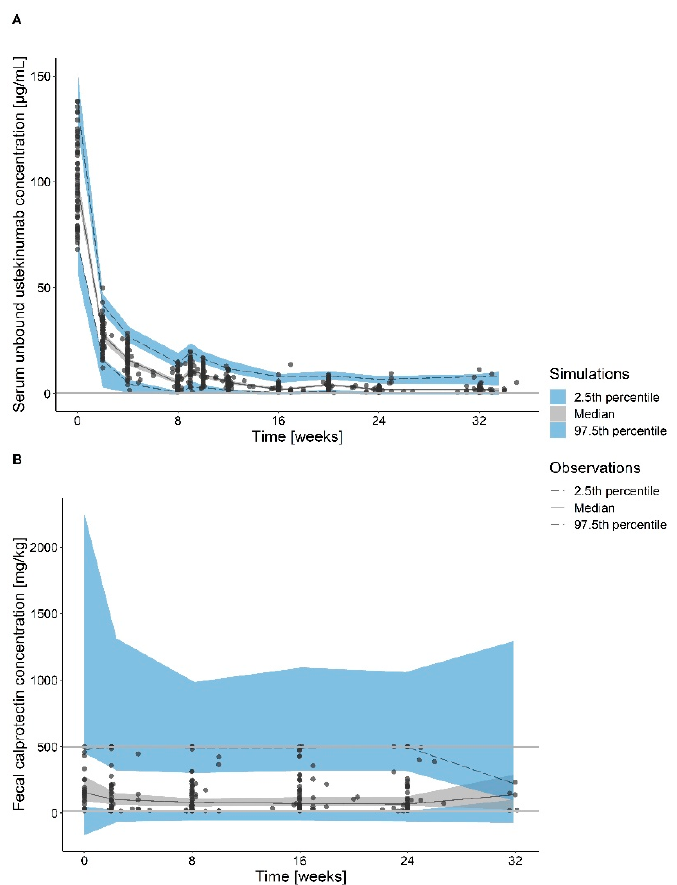
Figure 2. Visual predictive check (n = 2000) of the final pharmacokinetic ( A ) and final pharmacodynamic ( B ) models. Observations (points), medians (black lines), 5th and 95th percentiles (dashed black lines), 95% confidence intervals of the simulated medians (grey shaded areas), 2.5th and 97.5th percentiles (blue shaded areas). Table 3. Final pharmacodynamic model a parameter estimates.